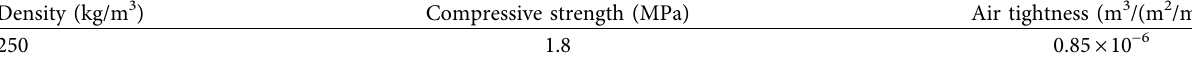
Table 3: Test results of properties of inorganic cured